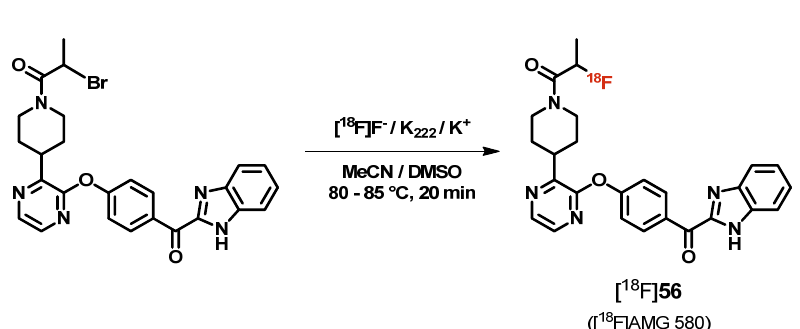
Scheme 17. Radiosynthesis of [ 11 C] 55 .